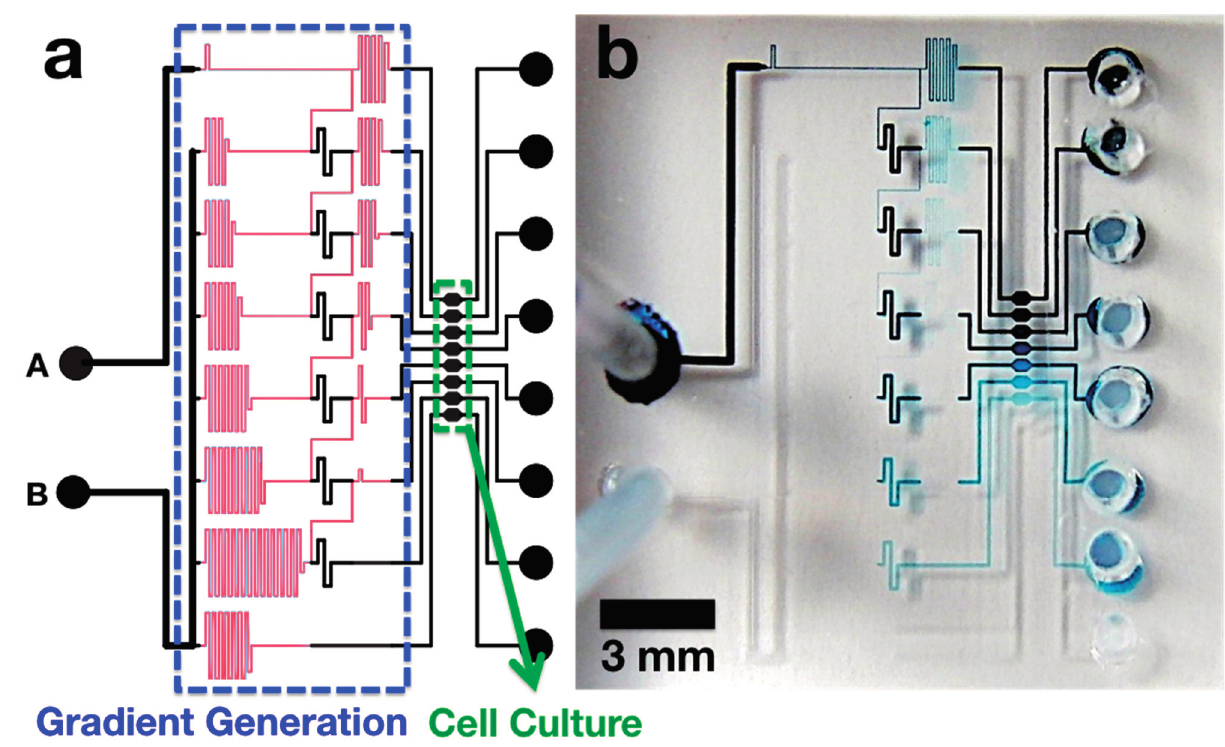
Figure 1. ( a ) An illustration of microchip design: black and red channels represent 149- μ m and 4- μ m tall features, respectively; ( b ) A photograph of the fabricated PDMS chip. Blue food dye solution and water were injected to upper ( A ) and lower ( B ) inlet ports,